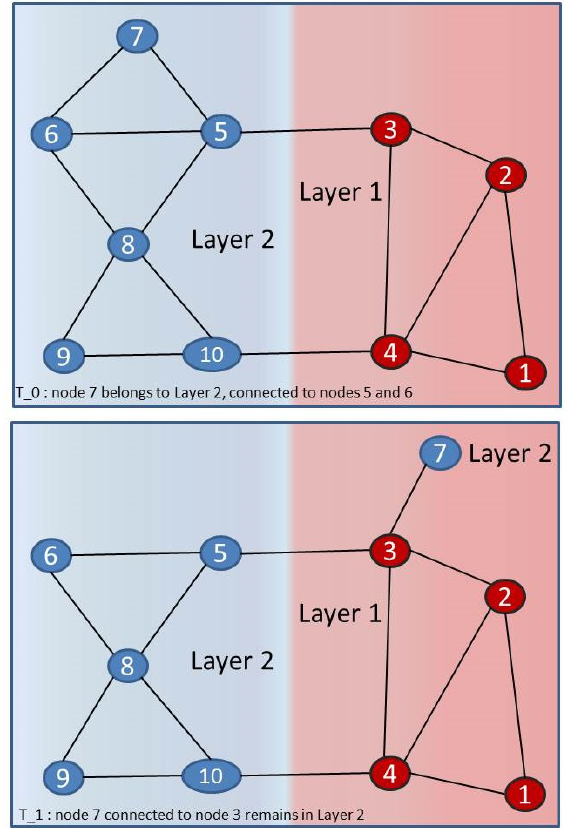
Figure 3. Example network with a moving